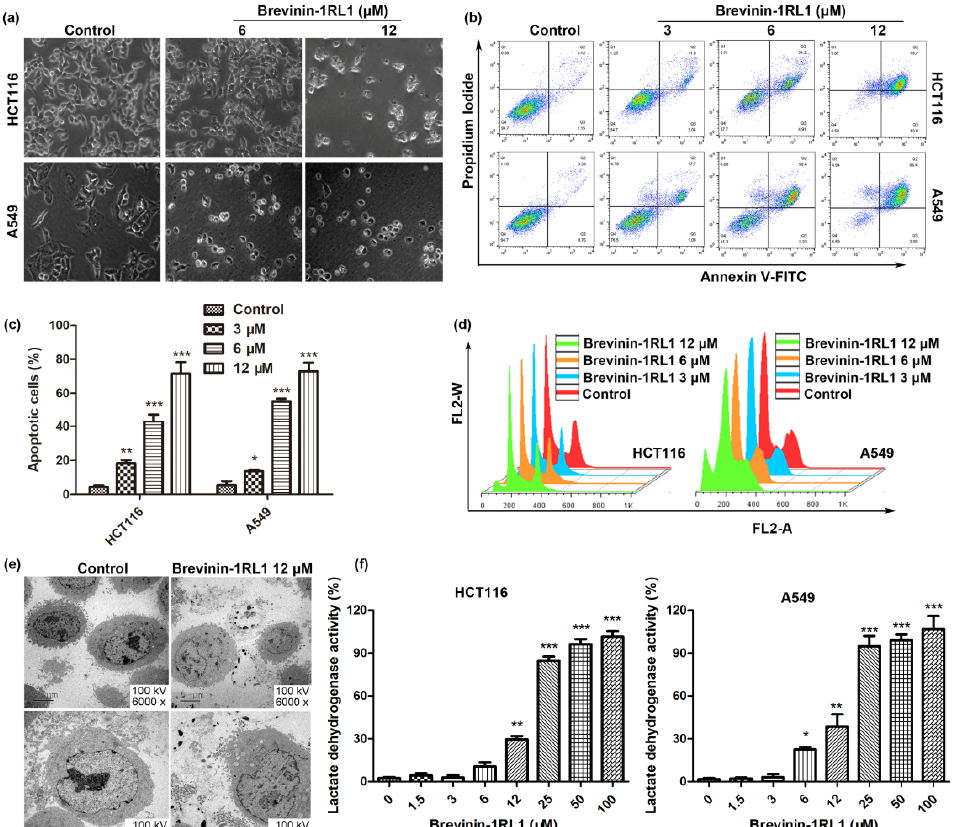
Figure 3. Brevinin-1RL1 induced cell apoptosis and necrosis in A549 and HCT116 cells. ( a ) The effect of Brevinin-1RL1 on morphological alteration of the tumor cell lines HCT116 and A549 cells was observed with Olympus microscope (Olympus Optical Co., Melville, NY). ( b ) Brevinin-1RL1 dose-dependently induced apoptosis of tumor cells. HCT116 and A549 cells were seeded in 6-well plates and co-incubated with different concentrations of Brevinin-1RL1 for 48 h. Apoptosis was then detected by flow cytometry using Annexin-V and PI double staining. ( c ) The apoptotic percentage of cells was statistically analyzed. ( d ) The distribution of cell cycle was detected by flow cytometry in Brevinin-1RL1 treated cells. HCT116 and A549 cells inoculated in 6-well plates were treated with indicated concentrations of Brevinin-1RL1 or control for 24 h. The cells were collected for propidium iodide (PI) staining and the cell cycle distribution was detected by flow cytometry. ( e ) Brevinin-1RL1 induced morphological hallmarks of cell necrosis. HCT116 cells were incubated for 12 h with and without Brevinin-1RL1 and the specific morphology of the cells was observed by TEM. ( f ) Brevinin-1RL1 induced the release of LDH in tumor cells. A549 and HCT116 cells were seeded in 96-well plates with 5 × 10 3 cells/well/100 μ L and incubated with different concentrations of Brevinin-1RL1 for 24 h. Cytoplasmic LDH release of cells was determined by the microplate reader. Each experimental data is three independent experiments. *p < 0.05, **p < 0.01, ***p < 0.001 in comparison to negative controls, and indicated the significant difference between the two groups. Data expressed as the mean ± SD (n = 3).